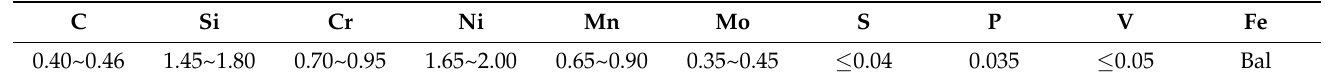
Table 2. Chemical composition of the as-forged 300 M steel (wt.%).